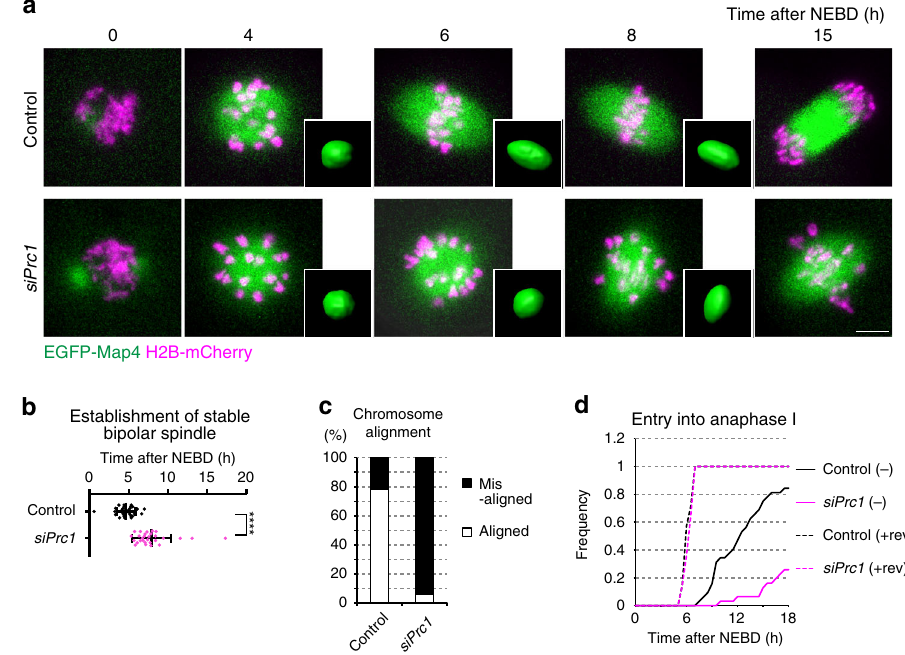
Fig. 3 Prc1 is required for timely spindle bipolarization in MI. a Live imaging of oocytes after Prc1 RNAi. Ndc80 f/f oocytes labeled with EGFP-Map4 (microtubules, green) and H2B-mCherry (chromosomes, magenta) were used. Spindle shapes were reconstructed in 3D. Four independent experiments were performed. Scale bar, 10 μ m. See also Supplementary Movie 6. b Prc1 depletion delays spindle bipolarization. Spindle shapes in 3D were categorized based on the aspect ratio, surface irregularity, and stability (see Methods). The plot shows the time at which a stable bipolar spindle was established ( n = 32, 29 oocytes from four independent experiments). Mean + / − SD are presented. **** p < 0.0001 ( p = 2.4E − 08) by two-tailed unpaired Student ’ s t -test. c Prc1 depletion increases chromosome misalignment. Oocytes were categorized into ‘ aligned ’ when all chromosomes located at the middle half of the spindle ( n = 32, 31 oocytes from four independent experiments). d Prc1 depletion causes a delay in anaphase I onset. Oocytes were incubated with or without the checkpoint inhibitor reversine (rev). The percentages of oocytes that underwent anaphase I onset were plotted ( n = 32, 31, 14, 14 oocytes from at least three independent